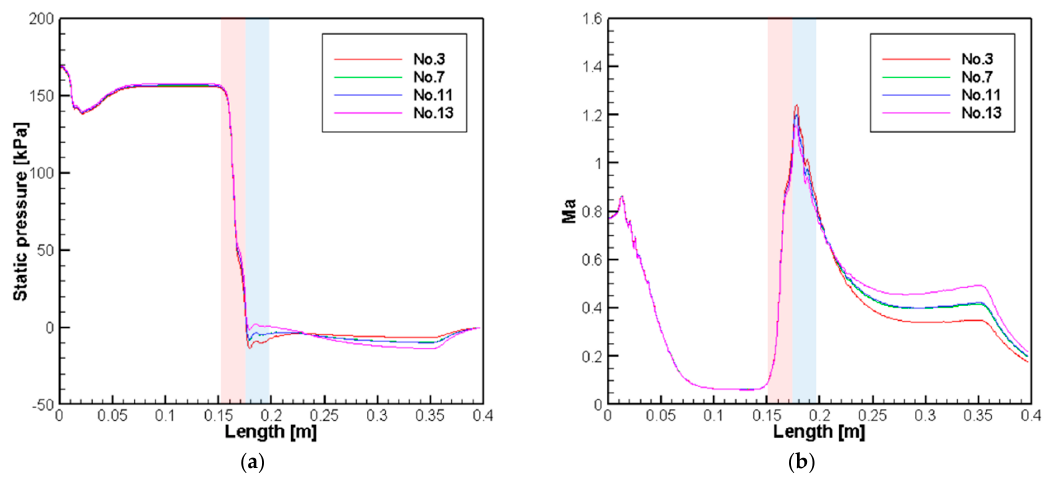
Figure 14. Comparison of the static gauge pressure and Mach number for the same air inlet total pressure: ( a ) static pressure; ( b ) Mach number (red: nozzle; blue: mixing section).